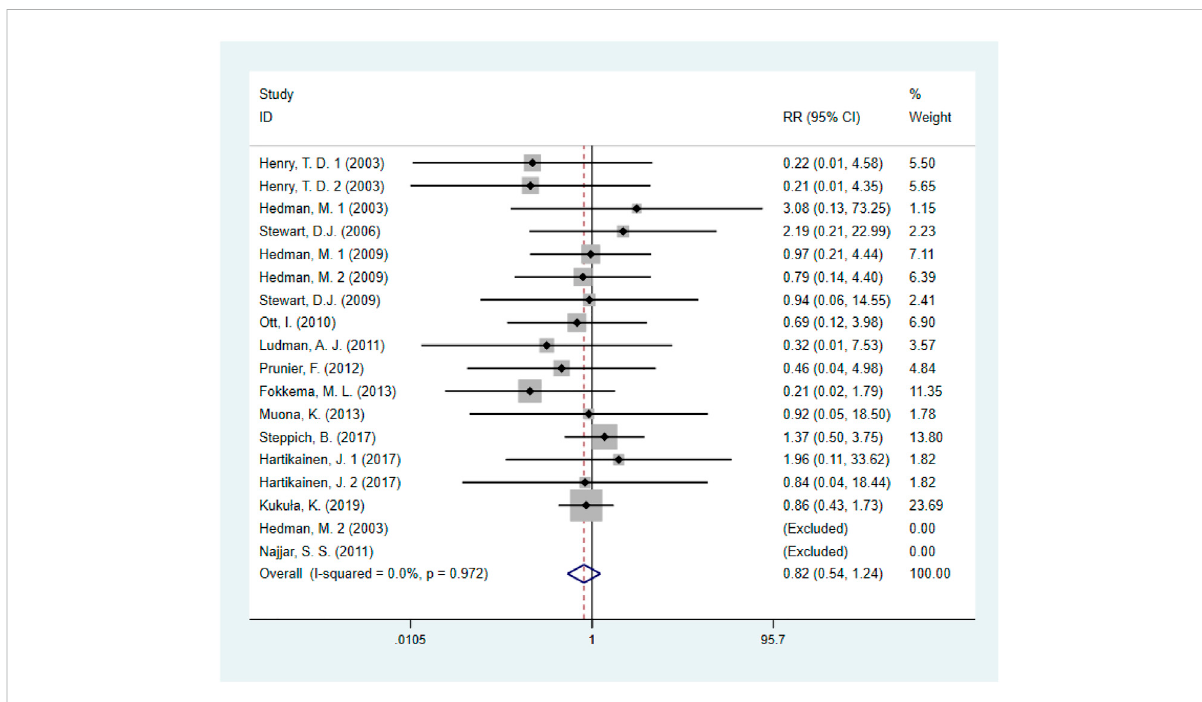
FIGURE 3 Forest plot for all-cause mortality, GF vs. control. RR, relative risk; CI, con fi dence interval; ID, identi fi